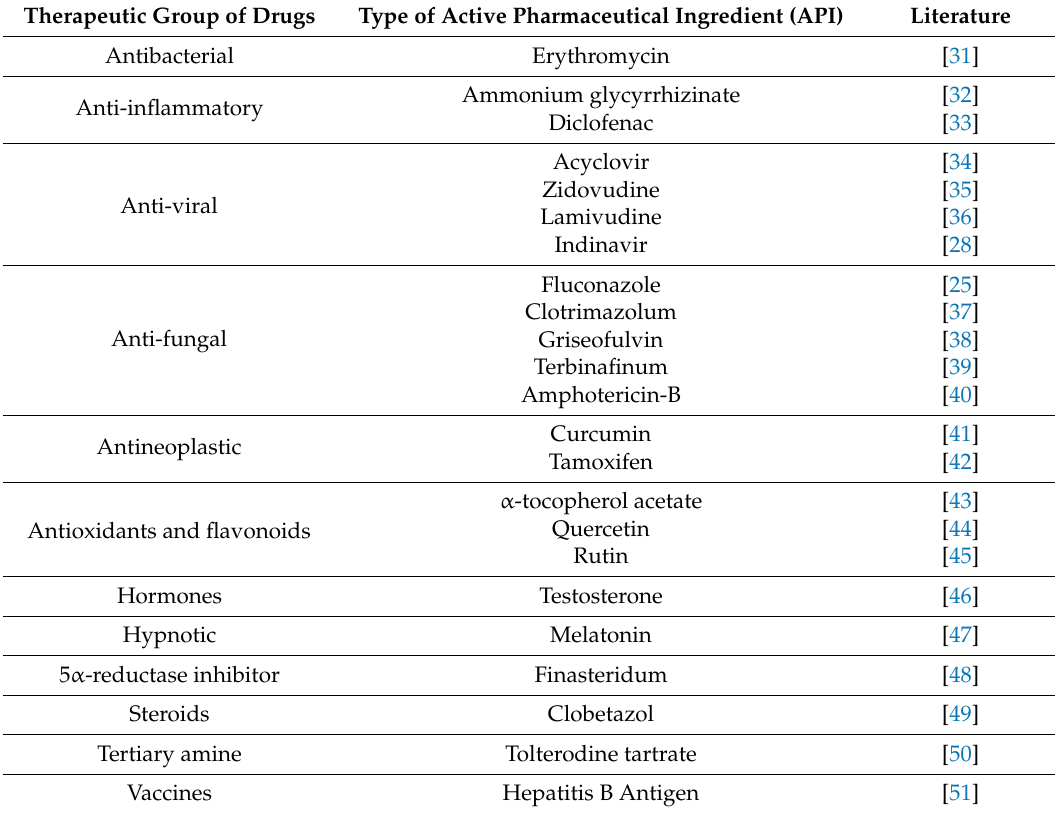
Table 1. The therapeutic groups of drugs encapsulated in